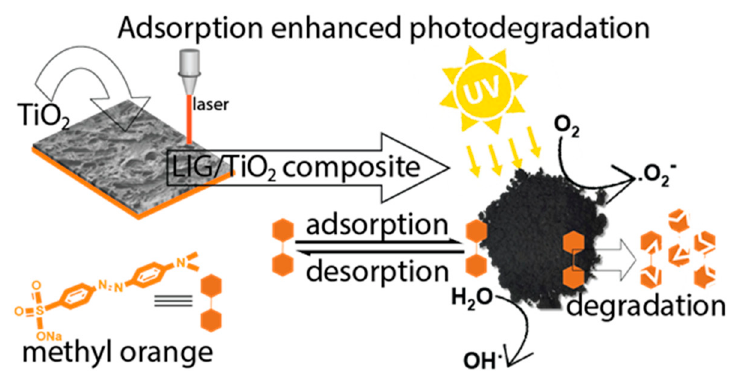
Figure 1. Schematic illustration of the fabrication of the LIG/TiO 2 , adsorption and the photodegradation process of methyl orange.